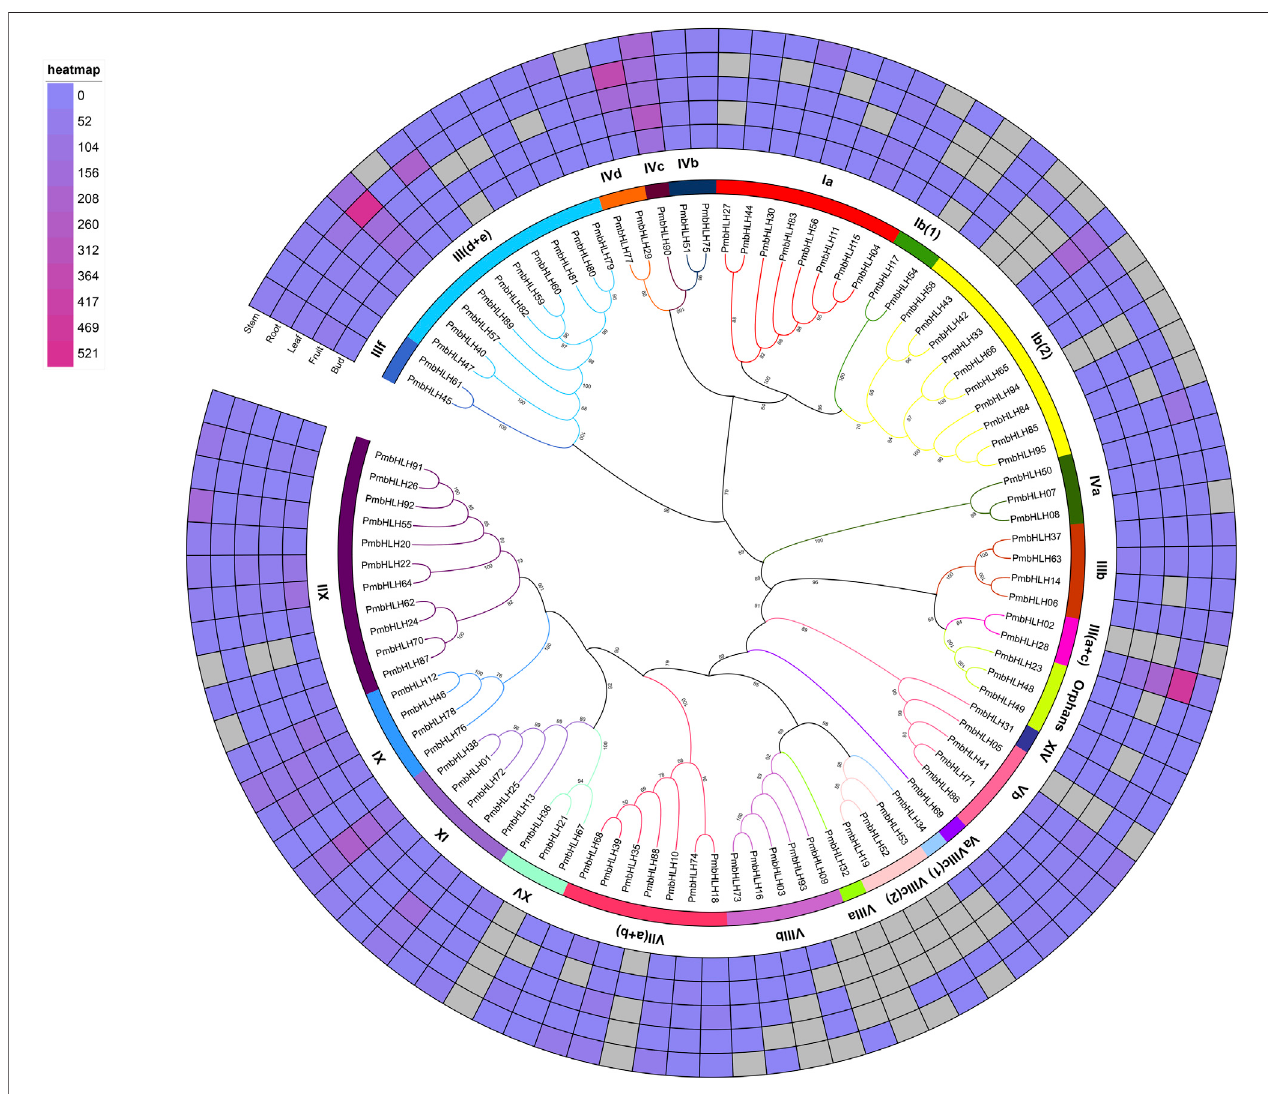
FIGURE 1 | Phylogenetic analysis of PmbHLH proteins in P. mume . The RAxML version eight software was applied to draw the Maximum likelihood (ML) tree with 1,000 bootstrap replicates. Lines with roman numerals represent different PmbHLH subfamilies. A heat map of PmbHLH genes in fi ve tissues (bud, fruit, leaf, stem, and root) was drew based on a phylogenetic tree. Color scores show the expression of PmbHLH genes in fi ve tissues.